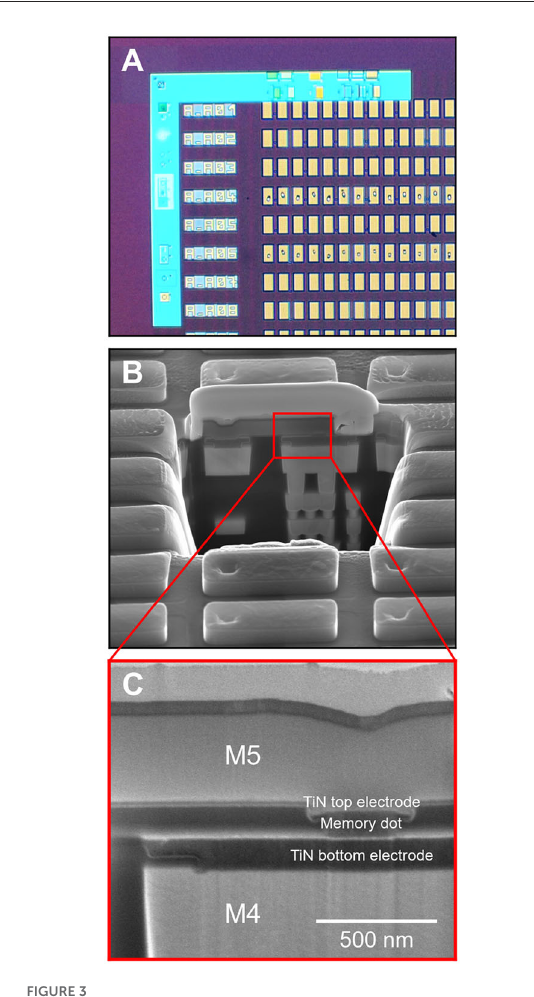
FIGURE3 Scanning electron micrographs of the ReRAM cell design used for electrical measurement. (A) shows an optical image of the array of contact pads, (B) shows a cross-section of a cell, and (C) shows a zoom-in of the resistive memory between metalization layers M4 and M5.